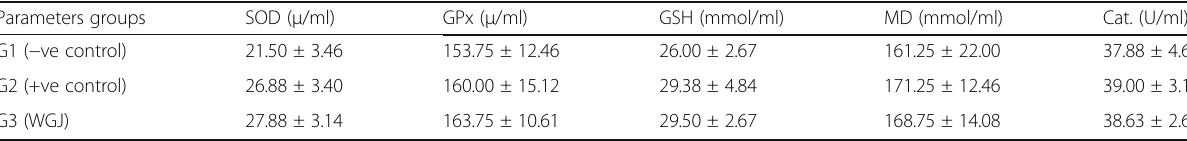
Table 8 The assessment oxidative enzyme of rats ’ blood Parameters groups